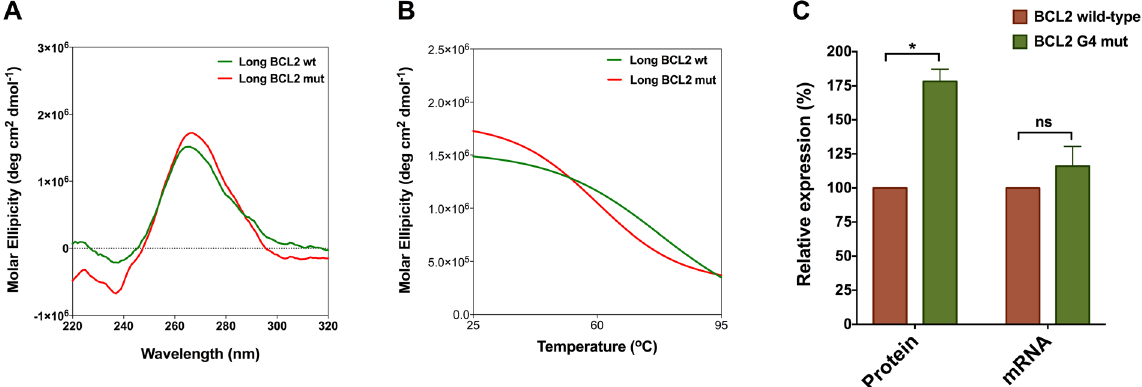
Figure 4. Further characterization of the RNA G4 destabilising mutation in the 5 ′ UTR of BCL2 ( A ) CD spectra of wild-type and mutated BCL2 oligomer which consist of 22 nucleotides predicted to form the G4 and 20 flanking nucleotides in KCl. ( B ) CD melting curves of wild-type and mutated BCL2 oligomer at 260 nm. ( C ) Gene expression level of wild-type and G4-mutated construct at the protein level as determined by dual luciferase assay and the mRNA level as determined by RT-qPCR. Data were analysed using multiple t-test (n ≥ 2, error bars represent the SEM, asterisks ( * ) indicate significance and ns indicates